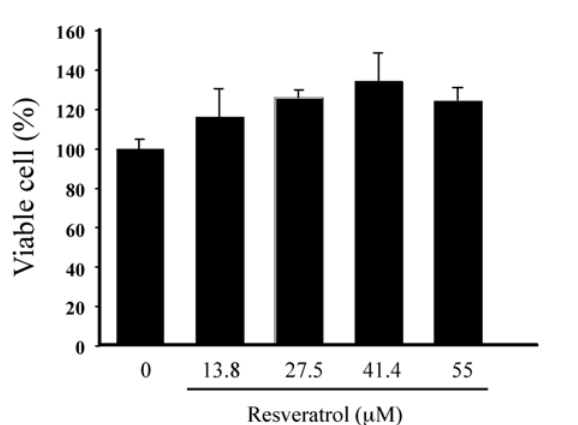
Figure 1. Effect of resveratrol on cell viability.